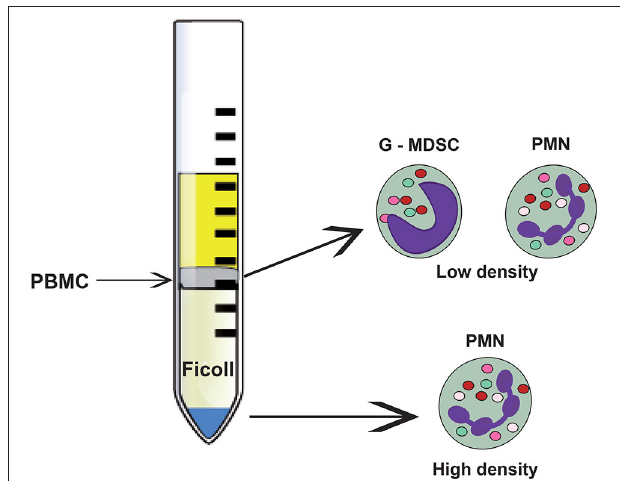
FIGURE 4 | Neutrophil subsets that can be separated through density gradient centrifugation. The bulk of mature (normal) neutrophils (PMN) are denser and separate at the bottom of the density gradient. These cells, named high-density neutrophils present the classical neutrophil morphology with a lobulated nucleus and many granules. In the upper part of the gradient, the less dense peripheral blood mononuclear cells (PBMC) are separated. Among these cells, low-density neutrophils can be found. They comprise immature and mature neutrophils with immunosuppressive properties. The immature population is also called granulocytic myeloid derived suppressor cells